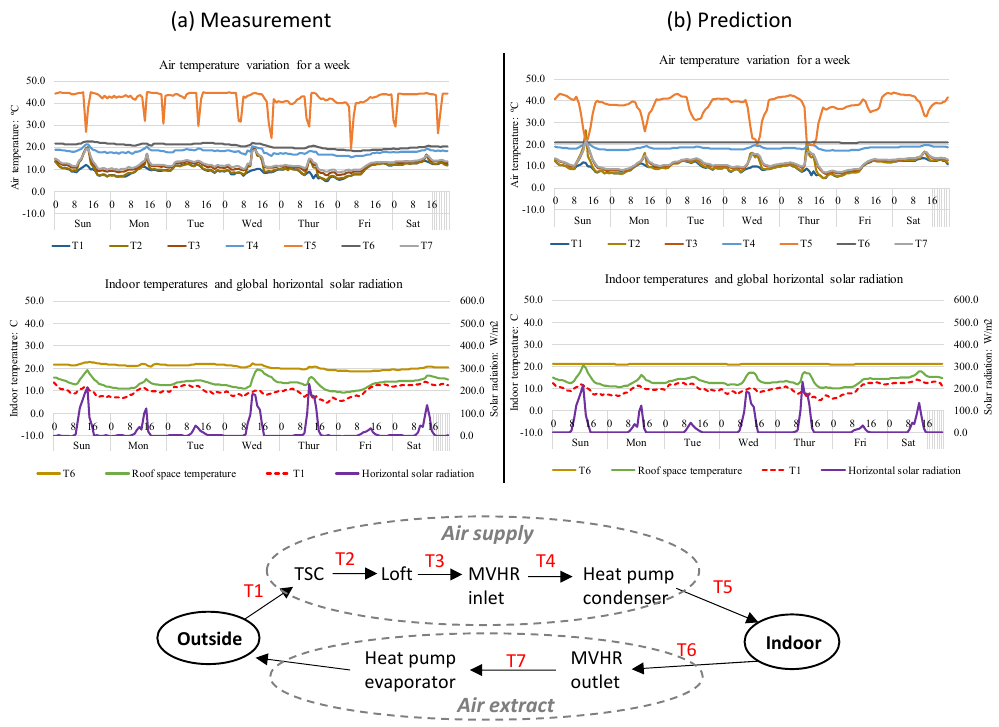
Figure 10. Comparison of measurements and predictions for the period 20–26 December 2015 ( a ) measured and ( b ) predicted. The diagram below the plots identifies the main measurement locations in the top graph.